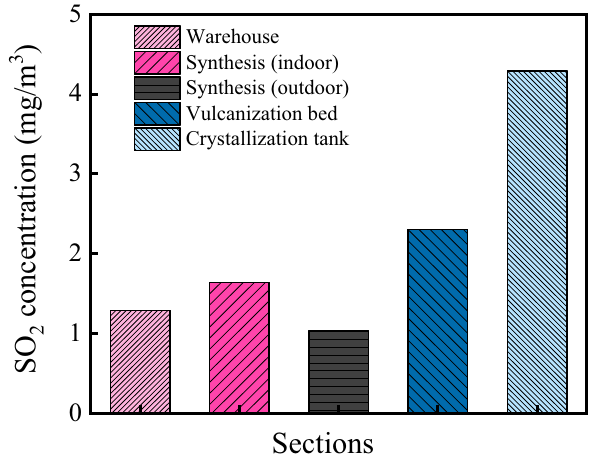
Figure 5. SO 2 concentration in the ammonium sulfate workshop.